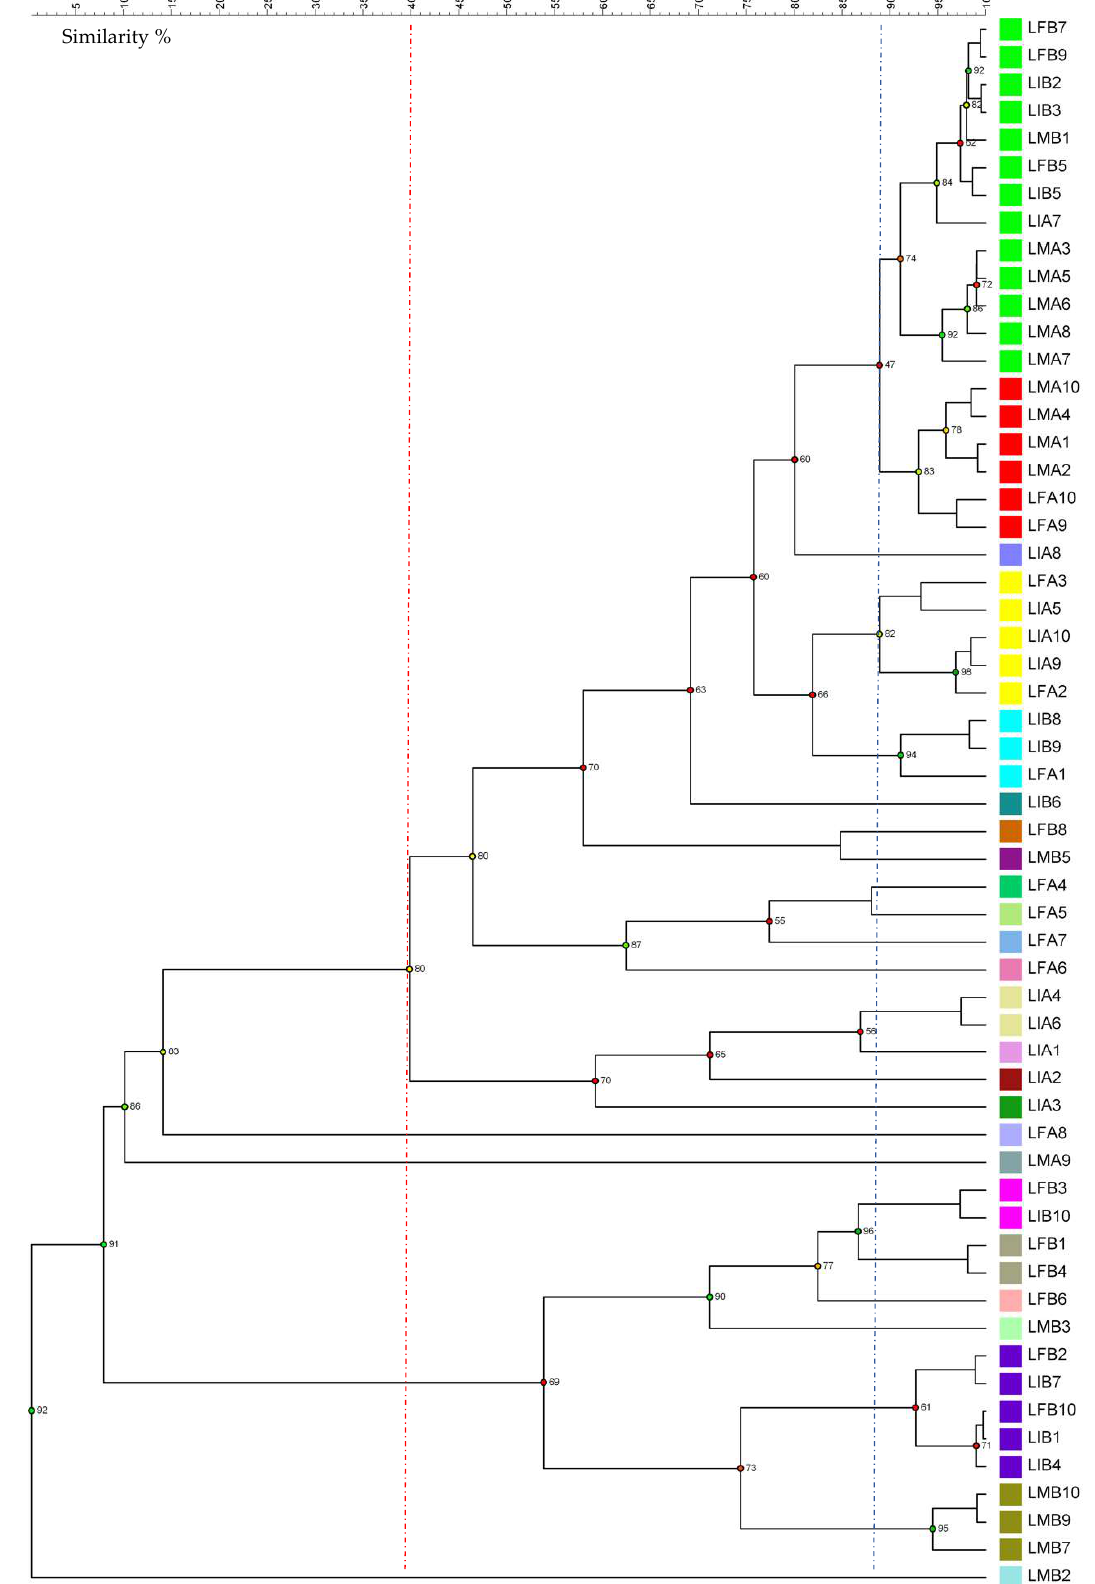
Figure 2. Dendrogram obtained from unweighted pair group method with arithmetic mean (UPGMA) analysis, using Pearson’s coefficient, of the (GTG) 5 rep-PCR patterns. The similarity threshold for biotypes discrimination was 89% (blue line). The cophenetic coefficient is represented by numbers and dots colored as red, orange, yellow, or green, based on the branch quality. Two major clades are distinct with a threshold of 40% (red